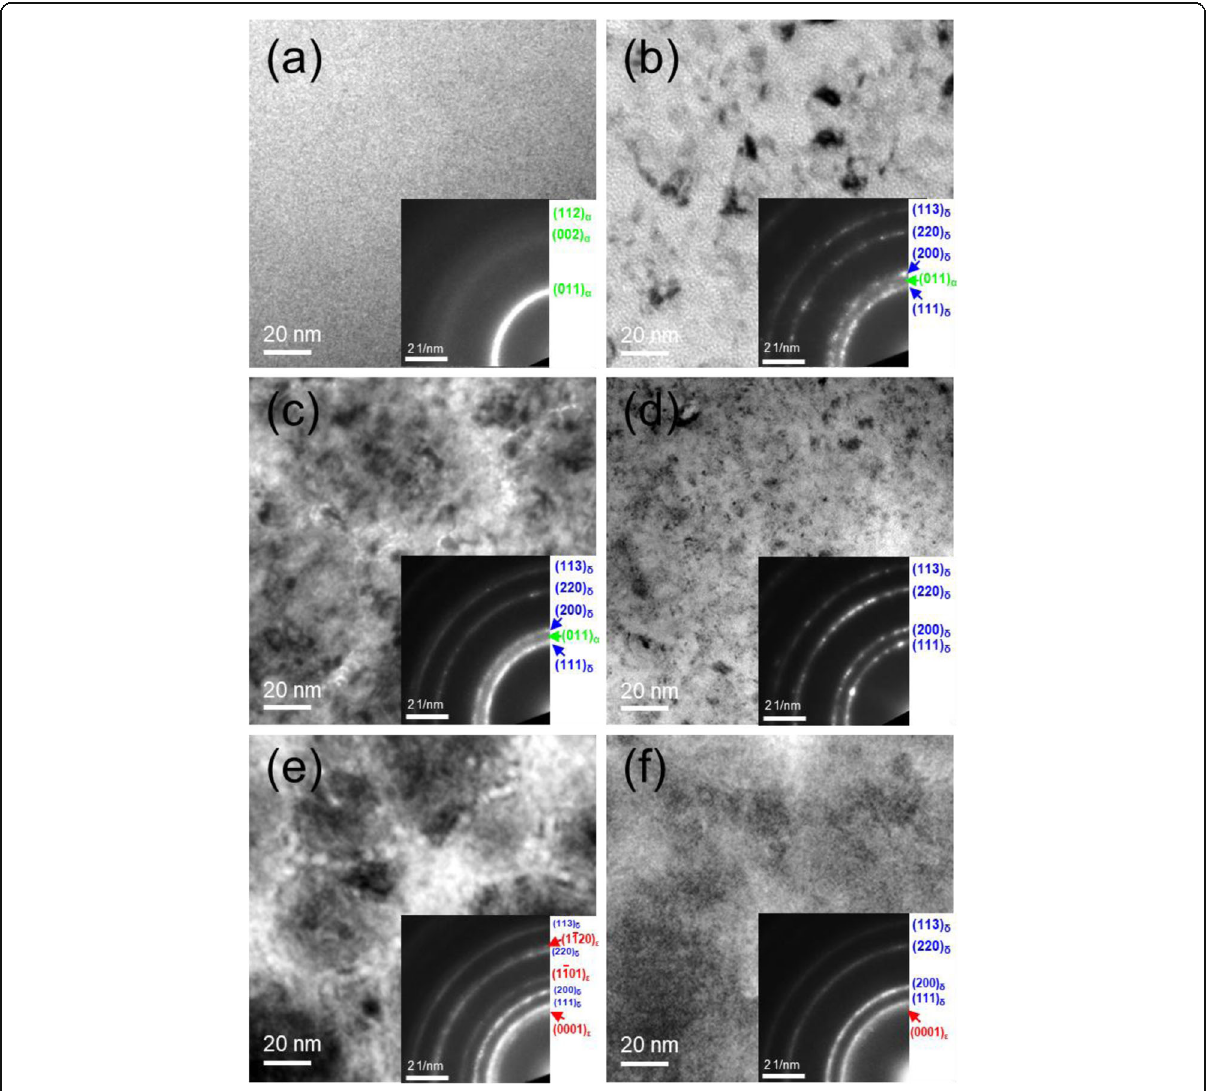
Fig. 2 Bright-field (BF) plan-view (P) TEM and selective area diffraction pattern (SADP) analyses of the top region of TaN x films grown with different nitrogen gas fractions ( f N2 ) and ICP powers (W). (a, b) 0.05 f N2 at 100 W and 400 W, (c, d) 0.1 f N2 at 100 W and 400 W, (e, f) 0.15% f N2 at 100 W and 400